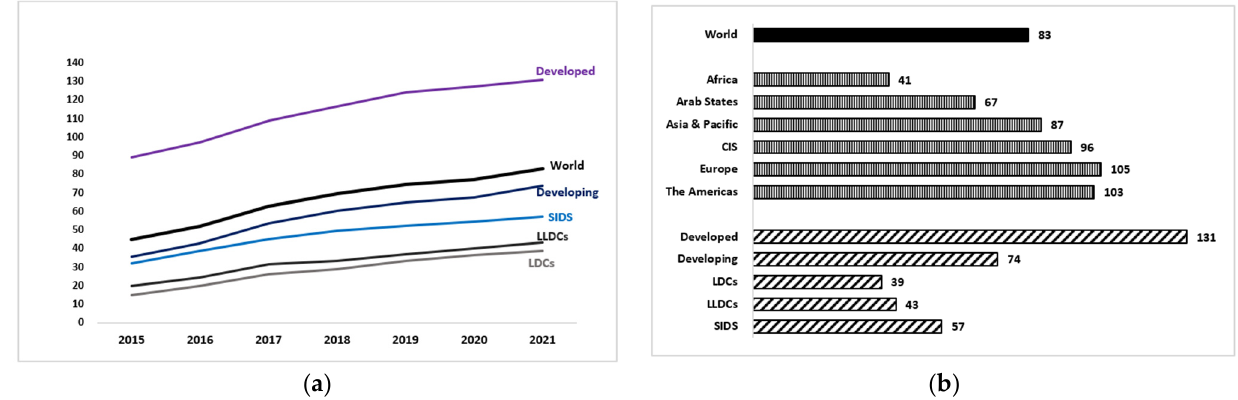
Figure 1. Active mobile broadband subscription per 100 inhabitants: ( a ) by development status; ( b ) by region.